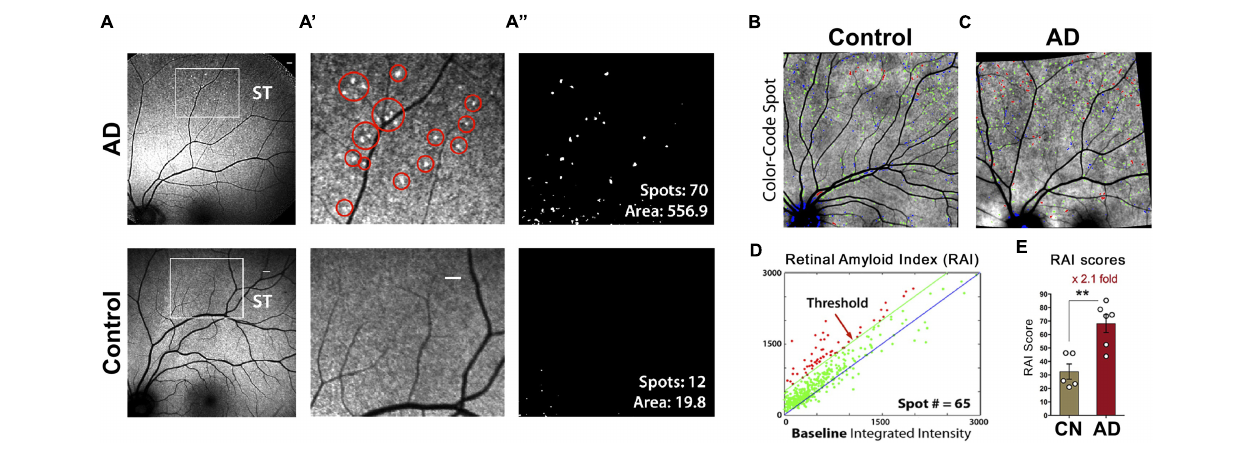
FIGURE 7 | Proof-of-concept clinical trial shows the feasibility of noninvasive in vivo retinal curcumin-amyloid deposit imaging in AD patients. (A) Representative images of curcumin fluorescence fundography, enabling detection of increased retinal curcumin spots in a living AD patient relative to minimal spots in a cognitively normal (CN) control subject; Regions of interest (ROI) in superotemporal (ST) retinas are demarcated by white rectangles. Scale bar: 400 µ m. (A’) Higher magnification image of the ROI with red circles highlighting curcumin-amyloid deposits in peripheral region of AD retina. (A”) Representative postprocessing images used to quantify spot number and fluorescent area ( µ m 2 ). (B,C) color-coded overlay images from CN (B) and AD (C) retinas with curcumin-positive amyloid deposits above threshold shown in red, spots above 1:1 reference but below threshold shown in green and spots below reference in blue. (D) Representative graph showing number of color-coded spots (described in B,C ) in AD retina used to determine retinal amyloid index (RAI) score. (E) Comparison of RAI scores in AD patients ( n = 6) and age-matched CN subjects ( n = 5). Data shown as group mean ± SEM. ** P < 0.005, unpaired 2-tailed Student’s t -test. Reproduced from Koronyo et al. (2017) with permission of ASCI via Copyright Clearance